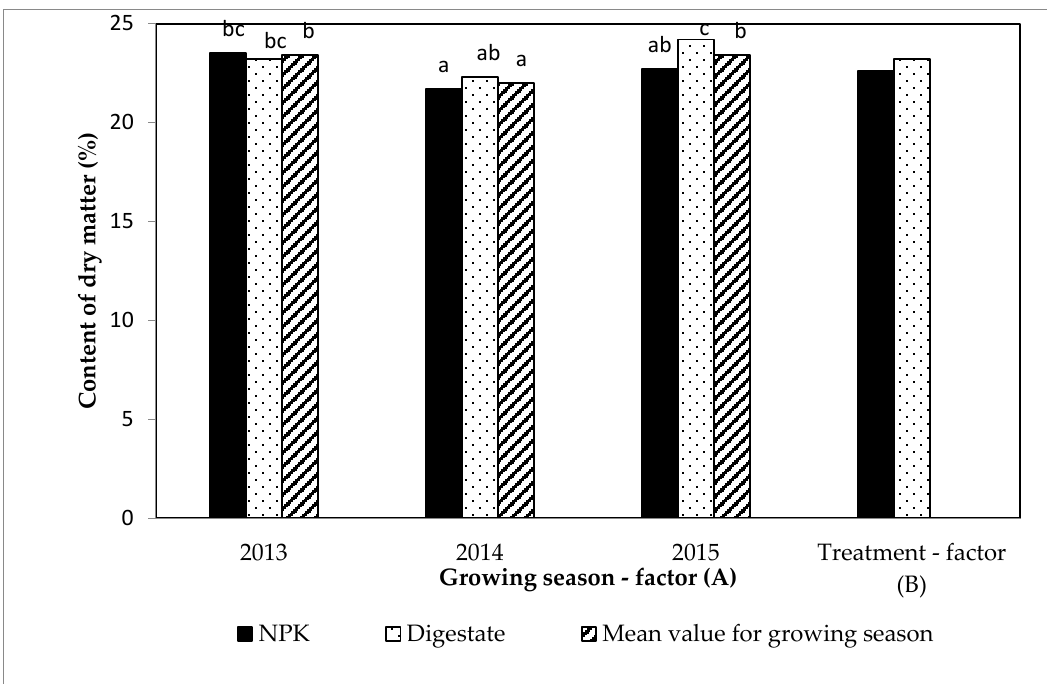
Figure 6. E ff ects of growing seasons and fertilization treatments on content of dry matter in sugar beet roots.